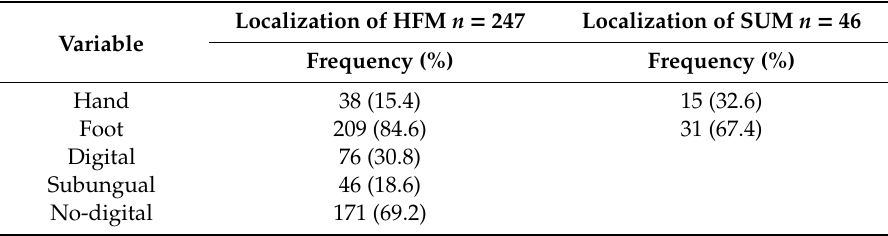
Table 3. Specific localization of HFM patients.